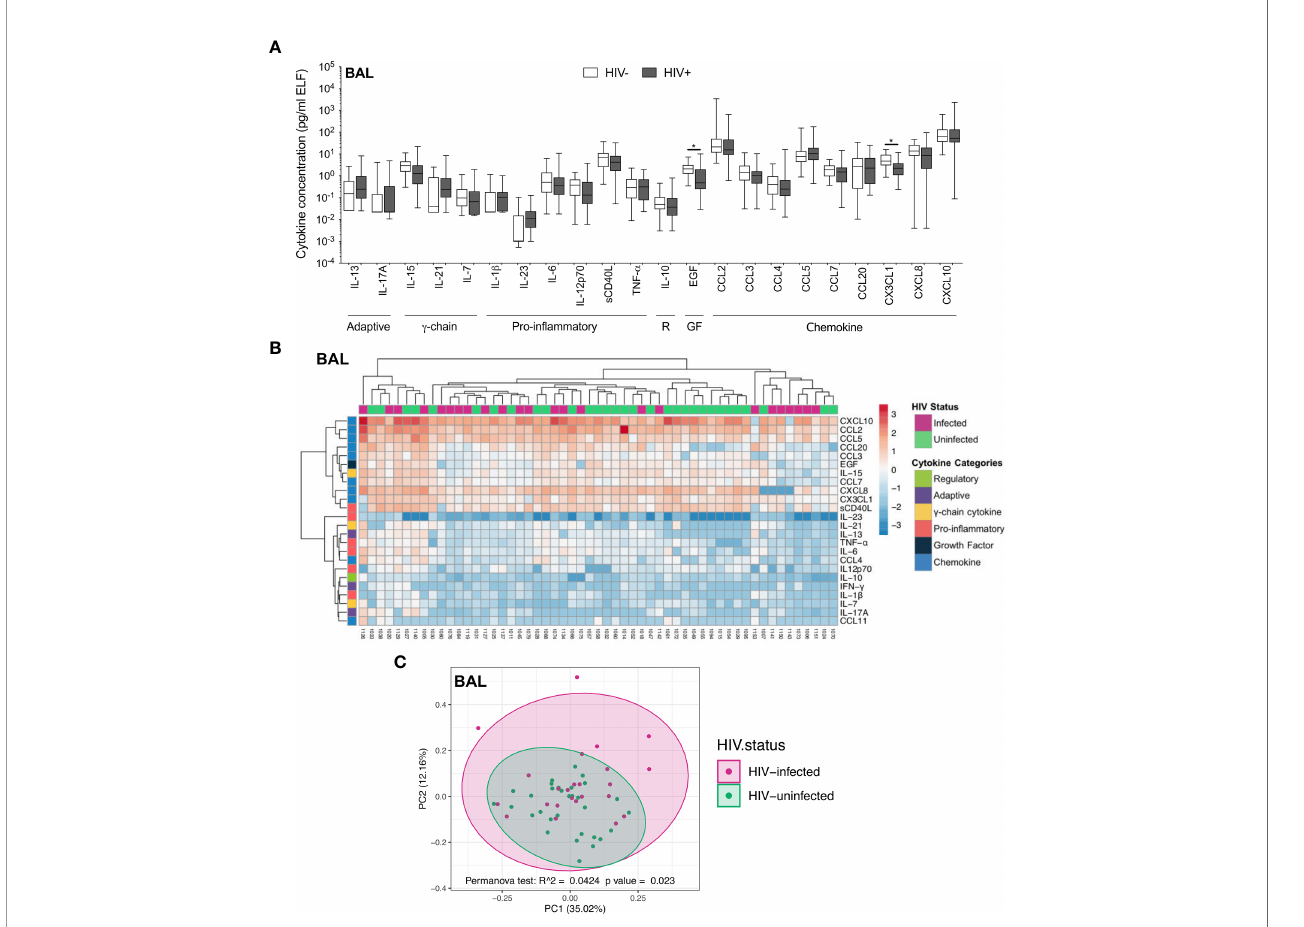
FIGURE 2 | Soluble immune mediators in BAL in HIV-infected and uninfected individuals. (A) Box and whisker plots (min-max) comparing cytokine concentrations in BAL according to HIV status. “ R ” refers to regulatory cytokines and “ GF ” refers to growth factors. Statistical analyses were performed using a non-parametric Mann- Whitney U test with False Discovery Rate (FDR) step down correction. (B) Unsupervised hierarchical clustering of cytokines in BAL. (C) Principal component analysis and permutational multivariate analysis of variance (permANOVA) of soluble immune mediators in HIV-infected (pink; n=24) and uninfected (green; n=31) participants. GM-CSF, IL-22, IL-4, IFN- g and CCL11 were excluded as they were below the level of detection. The p values, p ≤ 0.05, p ≤ 0.01, p ≤ 0.001, p ≤ 0.0001 are reported as *, **, *** and ****,